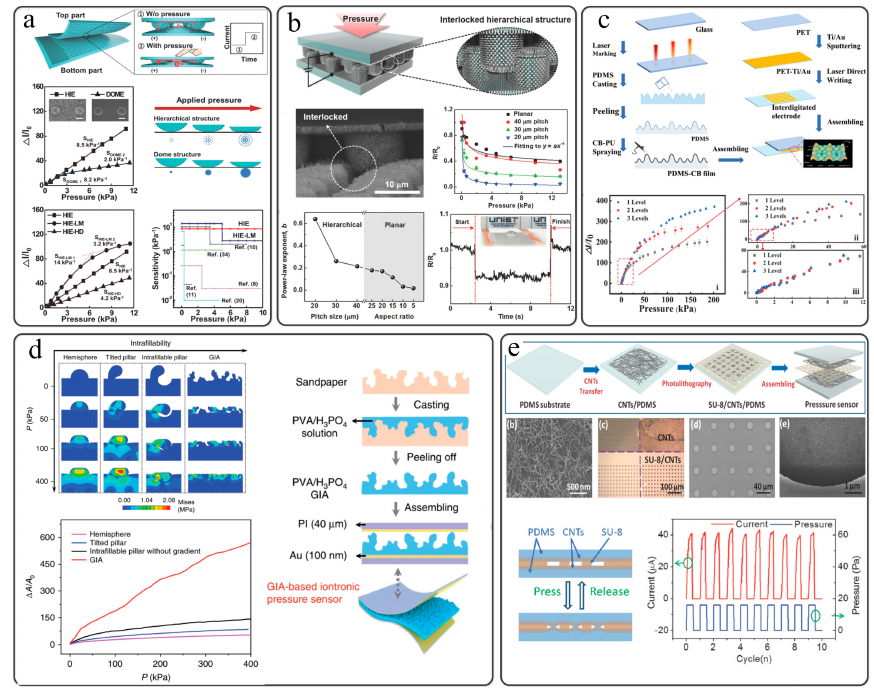
Figure 4. Method for adjusting the performance of flexible pressure sensor through device structure design. ( a ) Single-sided force-sensitive structure. Reprinted with permission from reference